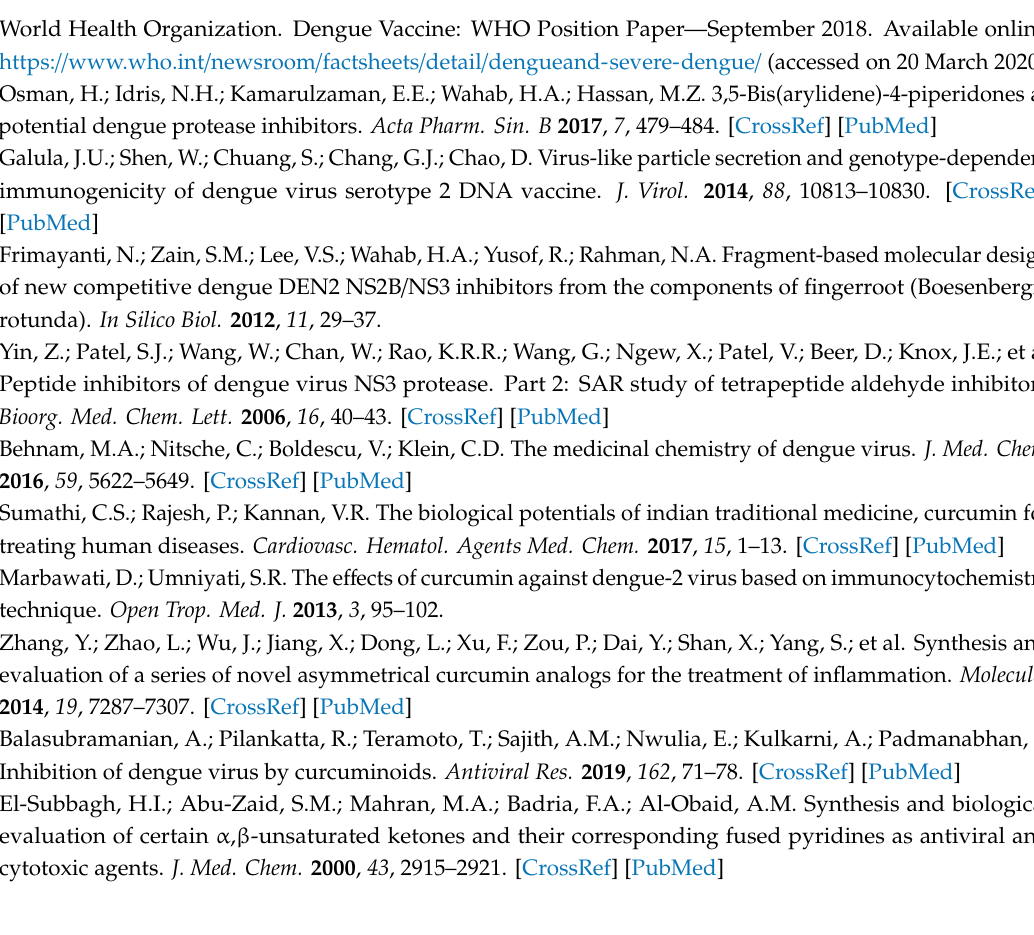
Supplementary Materials: The following are available online. Figure S1: 1 H NMR spectrum of 3 , Figure S2: 13 C NMR spectrum of 3 , Figure S3: Mass spectrum of 3 , Figure S4: FTIR of 3 , Figure S5: UV–Vis spectrum of 3